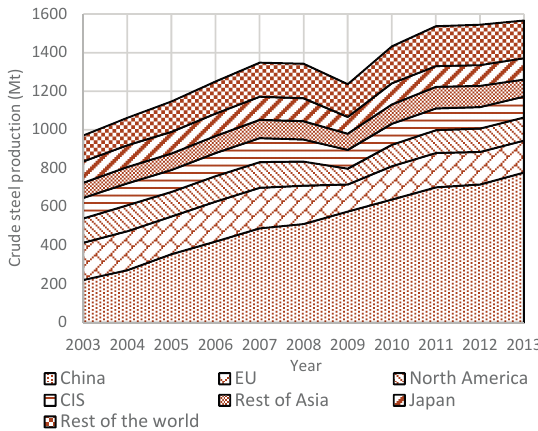
Figure 3. World crude steel production over the past decade highlighting major producing countries [6].